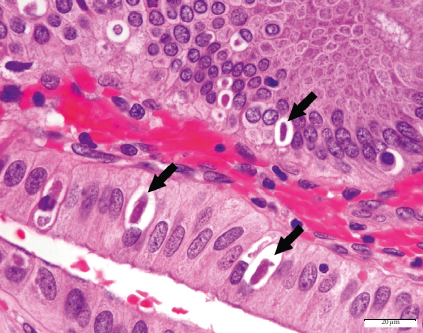
Figure 1: Donor gallbladder, H&E, 1000x. The characteristic morphology of Cystoisospori belli includes its banana-shape and perinuclear parasitophorous vacuoles (arrows) within the gall- bladder epithelium, as seen here.